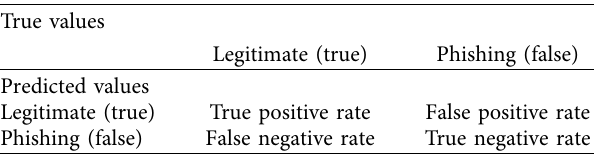
Figure 6: Time consumption for the proposed model using the BLSTM model. Table 3: Confusion matrix.